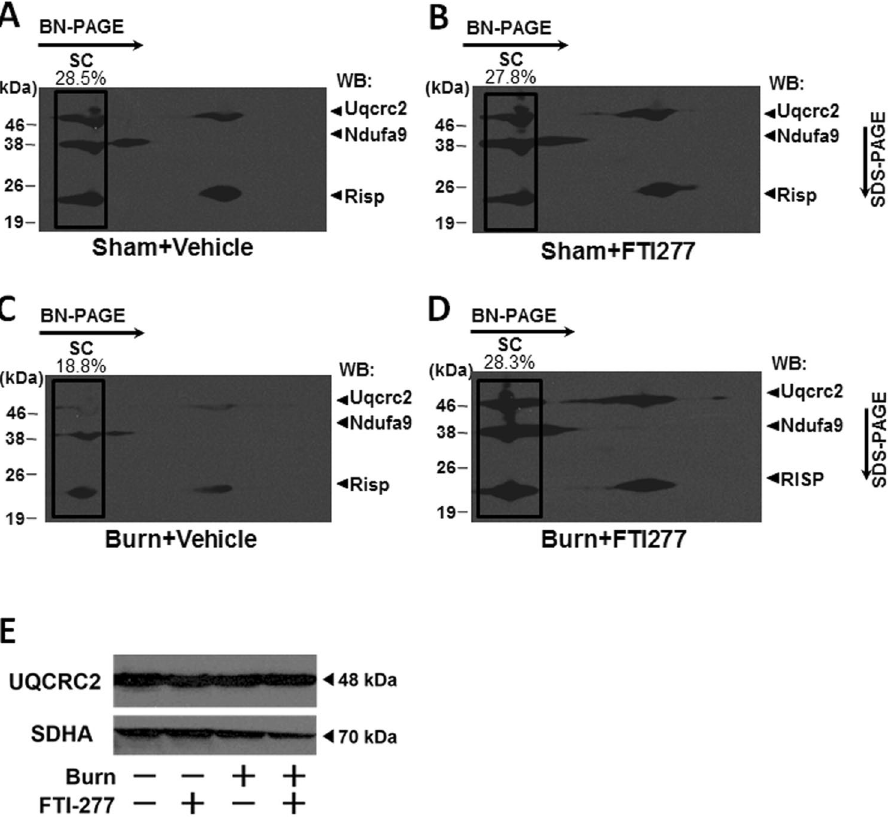
Figure 7. FTI-277 prevented burn-induced impaired mitochondrial respiratory supercomplex assembly in skeletal muscle. At 3 days after burn or sham-burn, respiratory supercomplexes in the mitochondria in skeletal muscle were separated by blue native (BN) PAGE followed by second-dimensional SDS-PAGE and visualized using antibodies for NDFUA9 (a component of complex I), and UQCRC2 and RISP (components of complex III). The percentage of the complex I-containing largest supercomplex (SC) signal intensity was decreased in vehicle-treated burned mice compared with sham-burned mice. FTI-277 treatment inhibited the burn-induced alteration in the supercomplexes. On the other hand, total protein abundance of UQCRC2 was not altered by burn injury or FTI-277 ( E ). SDHA (a component of complex II) was used as a control. WB: Western